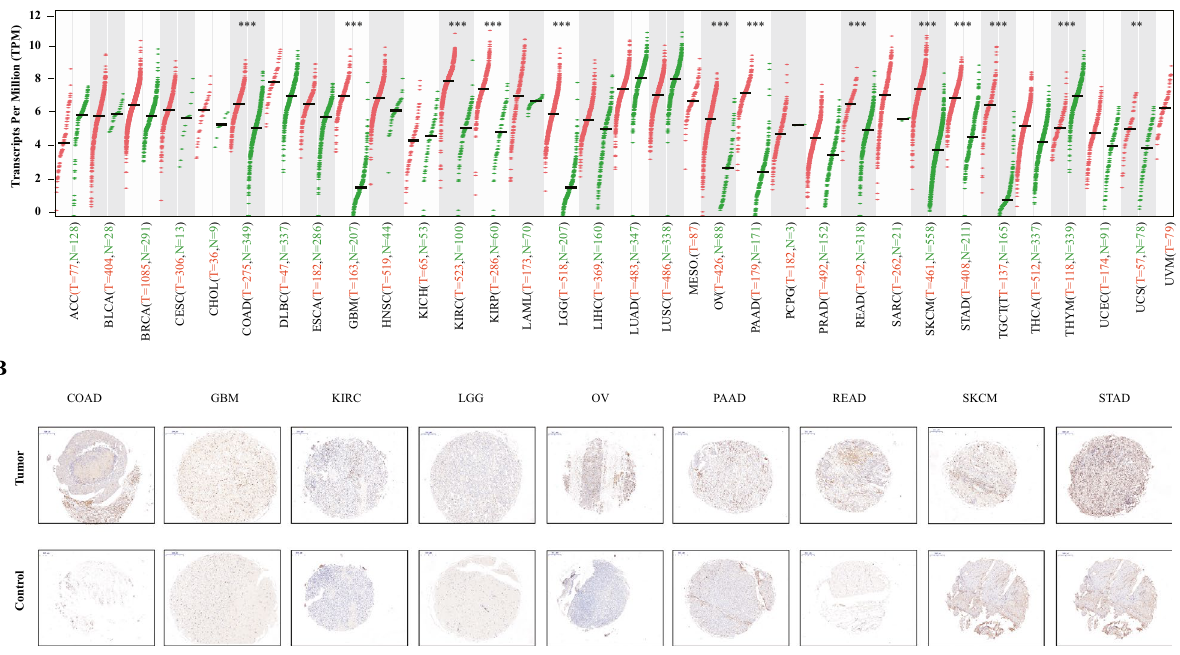
Figure 1. Expresssion aspect of CD68 in tumor and normal tissues based on the TCGA and GETx databases. CD68 expression from the TCGA and GTEx databases ( A ). CD68 expression from tumor tissue chip using immunohistochemistry, n = 3 for tumor/control groups in COAD, GBM, KIRC, LGG, OV, PAAD, READ, SKCM, and STAD ( B ). *P < 0.05, **P < 0.01, ***P <